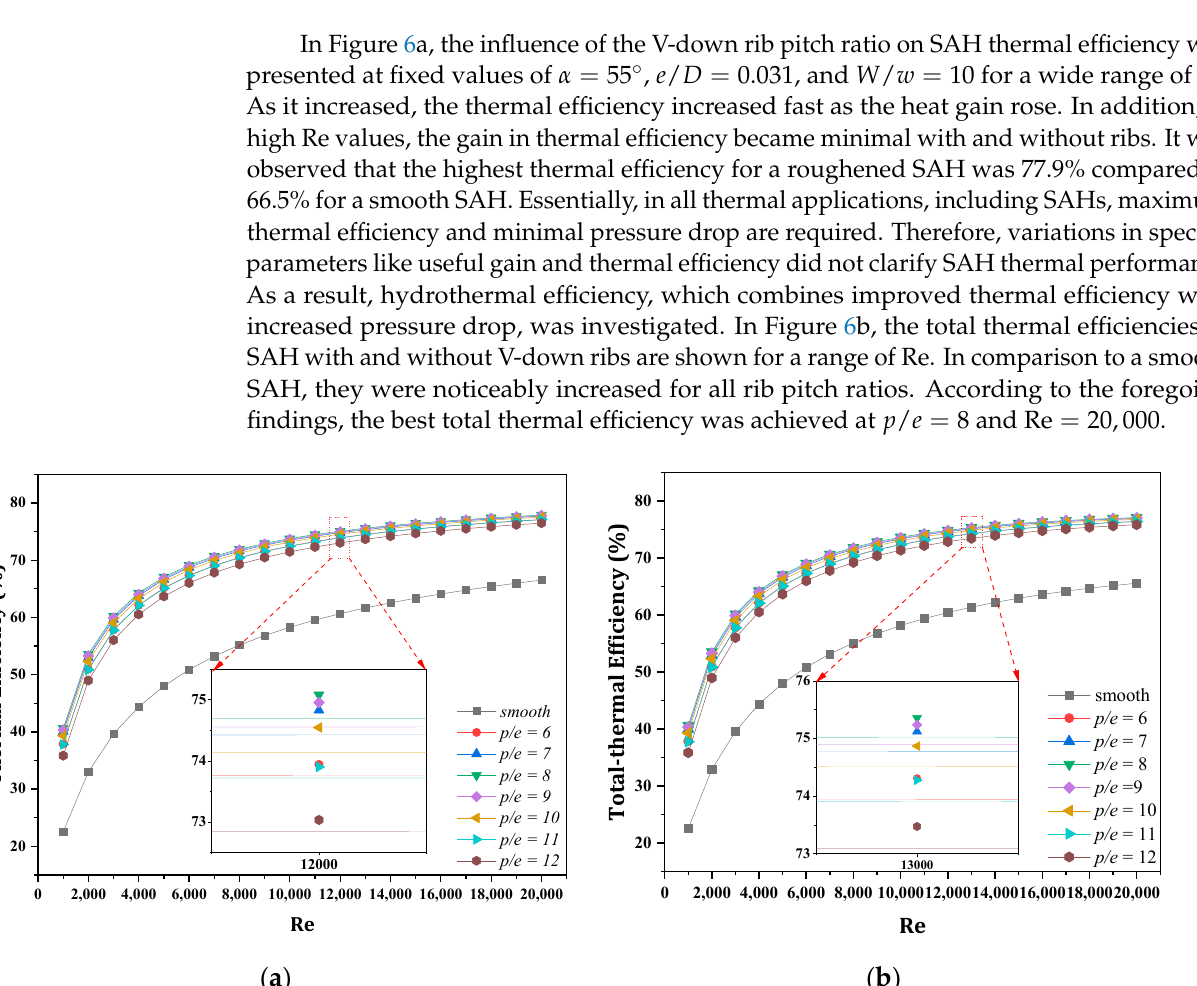
Figure 7. Useful energy (W) versus Re for smooth and roughened surfaces at various relative rough- ness heights 𝑒 𝐷⁄ (in the range of 0.043 – 0.019 ). The influence of relative roughness height on thermal efficiency over a wide range of Re is presented in Figure 8. It shows that there was a considerable gain in thermal effi- ciency when the V-down ribs were used at the lowest Re value, and that this improvement enhanced the increasing relative roughness height 𝑒 𝐷⁄ . For a specific value of 𝑒 𝐷⁄ , this improvement was observed to be beneficial at a low Re and diminished with rising Re